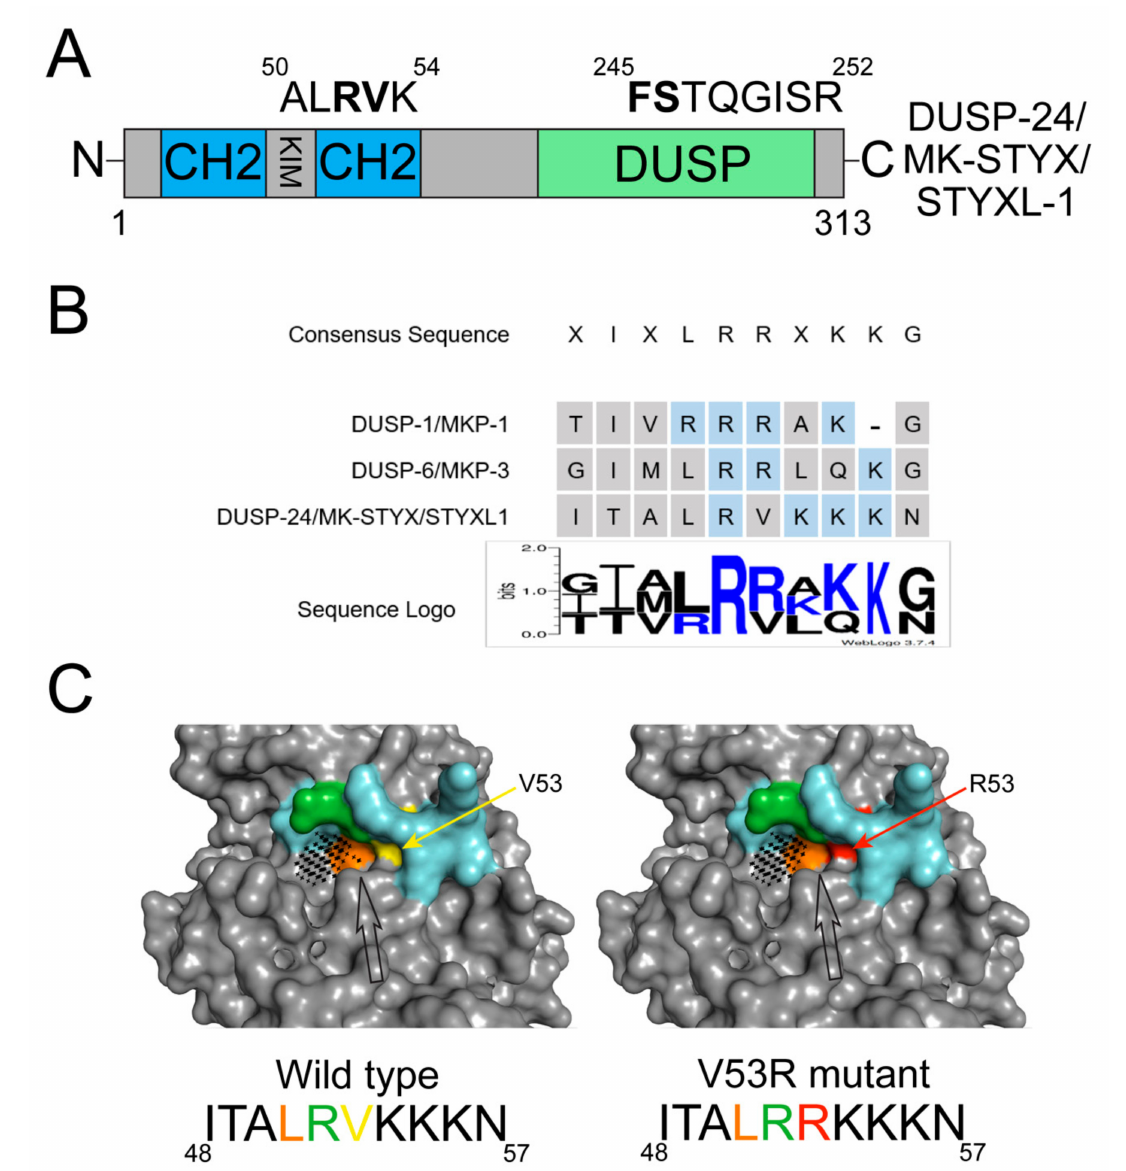
Figure 3. Bioinformatics structural analysis of pseudophosphatase MK-STYX. ( A ) The atypical domains of MK-STYX. MK-STYX has a C-terminal DUSP domain and an N -terminal CH2 domain, similar to its active homologs. A mutation in the active site of the DUSP domain from HCX 5 R to FSX 5 R renders MK-STYX catalytically inactive. In addition, the presumed kinase-interacting motif (KIM) within the CH2 domain of MK-STYX lacks consecutive arginine residues, required for MAPK binding. Therefore, MK-STYX may not bind MAPKs. ( B ) The KIM analysis of MK-STYX and active homologs, MKP-1 and MKP-3. The KIM regulates substrate specificity and substrate docking in CH2 domain of classical MKPs. The KIM requires 2 to 3 consecutive arginine residues to create a consecutive positively charged region that interacts with the negatively charged aspartic acid residues on the target MAPK substrate for docking of the MAPK. Unlike its active homologs, MKP-1 and MKP-3, the KIM consensus motif of MK-STYX contains only a single arginine. This may explain why MK-STYX does not bind and regulate MAPKs in the same manner as typical MKPs. The sequence logo was made using WebLogo 3.7.4 [59] and has a 2.0 bit scale (positive residues are shown in blue, neutral residues are shown in black, no negative residues are present). ( C ) Computational mutagenesis of the KIM of MK-STYX affects the size and shape of a predicted binding pocket. To probe for possible explanations behind why MK-STYX lacks the ability to regulate MAPK signaling, a predictive model of the macromolecular structure of MK-STYX was generated by Iterative Threading ASSEmbly Refinement (I-TASSER) [60]. The best I-TASSER model (validated through MolProbity [61] with a score of 3.03) was refined using DeepRefiner